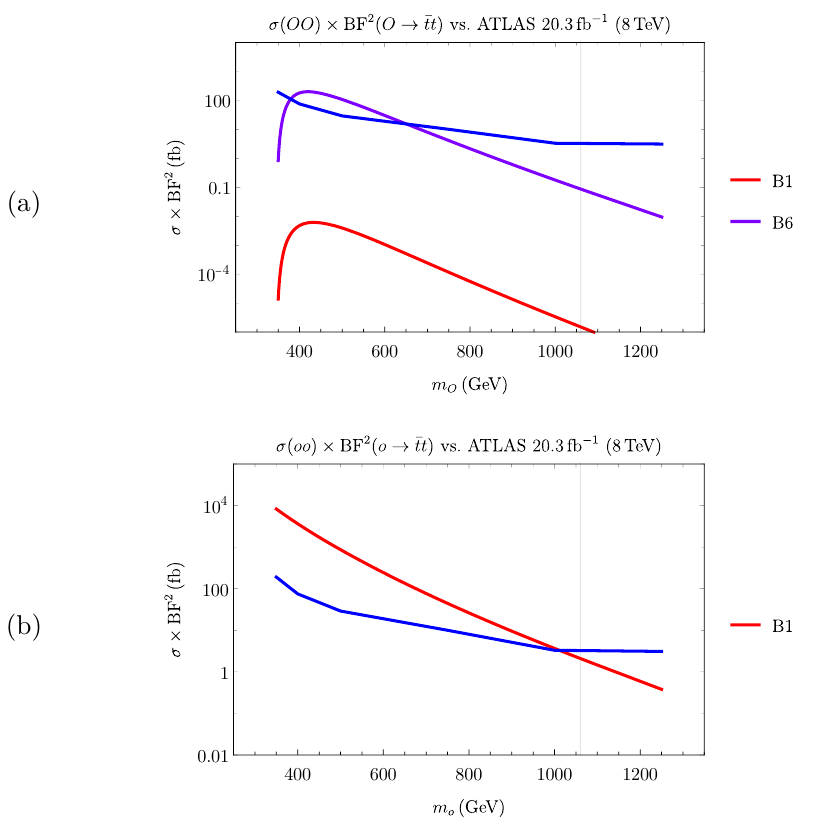
Figure 13. Cross sections in benchmarks B1 and/or B6 of (a) scalar sgluon and (b) pseudoscalar pair production with subsequent decays to top-antitop pairs compared to exclusion bound from ATLAS 20.3 fb (cid:0) 1 (8 TeV) four-top event search for color-octet scalars assuming BF( O or o ! (cid:22) tt ) = 1. Exclusions are denoted by blue lines. Gray lines mark ATLAS lower limit (cid:24) 1.06 TeV for the mass of a complex color-octet